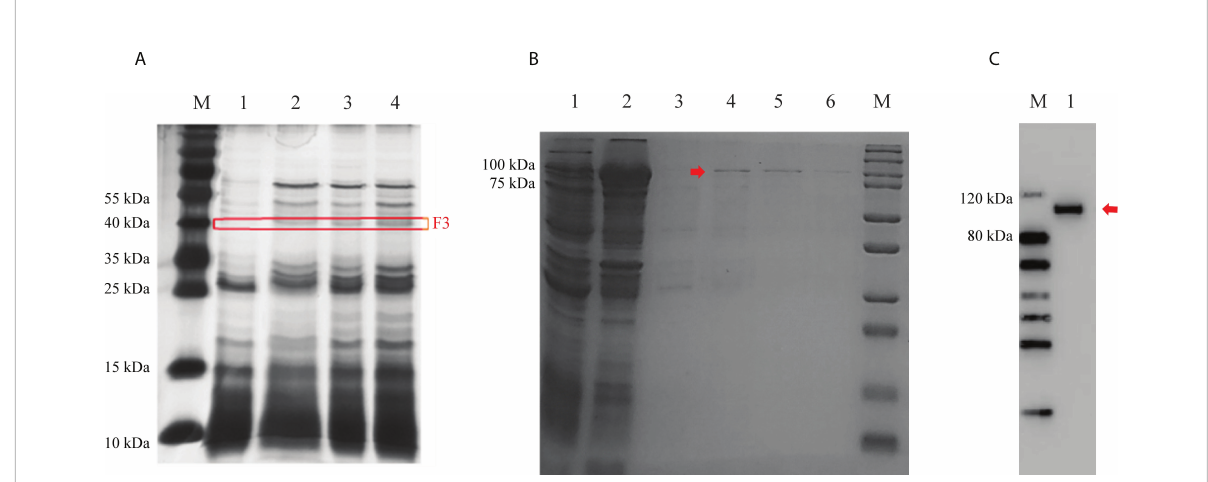
FIGURE 3 Identi fi cation of Cry7Ab4 toxin-binding proteins from the midgut juice of P. xylostella larvae and expression of recombinant BJSP-1-GST. (A) Proteins in the midgut juice of P. xylostella larvae that bound to Cry7Ab4 were identi fi ed by protein pull-down assay and analyzed by SDS-PAGE. M, marker; lane 1, CNBr-activated Sepharose 4B + P. xylostella midgut juice (control); lanes 2, 3, and 4, CNBr-activated Sepharose 4B + Cry7Ab4 (25 m l) + P. xylostella midgut juice (50 m l). The red box (F3) indicates protein bands of Cry7Ab4 toxin-binding proteins. (B) Expression and puri fi cation of recombinant P. xylostella BJSP-1-GST analyzed by SDS-PAGE. Lane 1, supernatant containing BJSP-1-GST from bacterial cell lysates; lane 2, pellet from bacterial cell lysates; lane 3, washing fraction (50 mM Tris – HCl, pH 8.0); lanes 4 – 6, fi rst, second, and third elution